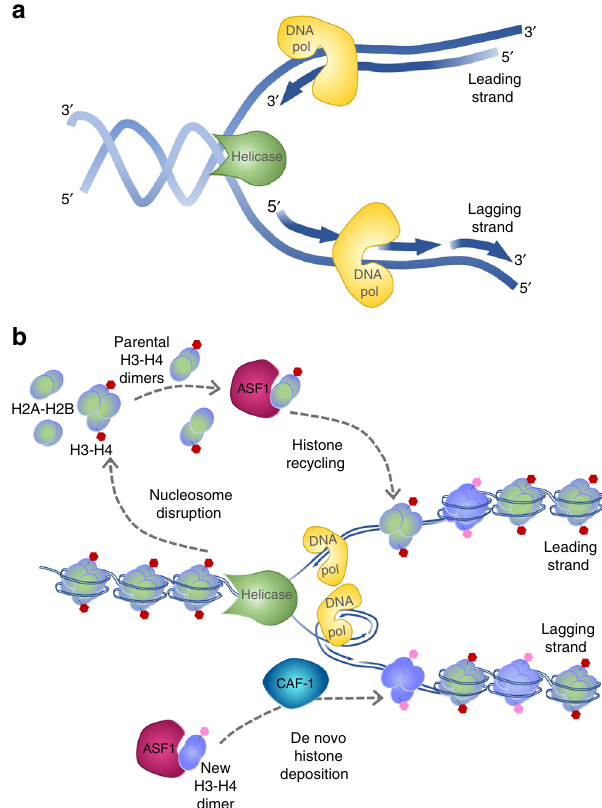
Fig. 1 Inheritance at the replication fork. a The Naked DNA Paradigm: although the classical semi-conservative model of DNA duplication is useful for explaining Mendelian genetics, the model of DNA in isolation is imperfect for most nuclear processes that require the cooperation of DNA with nuclear proteins, such as inheritance during S-phase, which requires more than just passing a gene to daughter cells. This model simply shows DNA strands unwound at the replication fork by helicase, which is followed by the leading and lagging strands of DNA replication by DNA polymerase. b A modern model for inheritance: the more complete model of inheritance, which includes the DNA along with chromatin. At the replication fork, nucleosomes are disrupted to provide access to the DNA polymerase for DNA duplication. These displaced parental histones (shaded green-purple) are reassembled after fork passage with the assistance of chaperone proteins, such as ASF1. In addition, new histones (purple) are required to fully reconstitute chromatin on the two daughter strands, which is also facilitated by chaperone proteins, including ASF1 and CAF-1. New histones acquire marks in accordance to the pattern carried by the parental histones to inherit gene expression